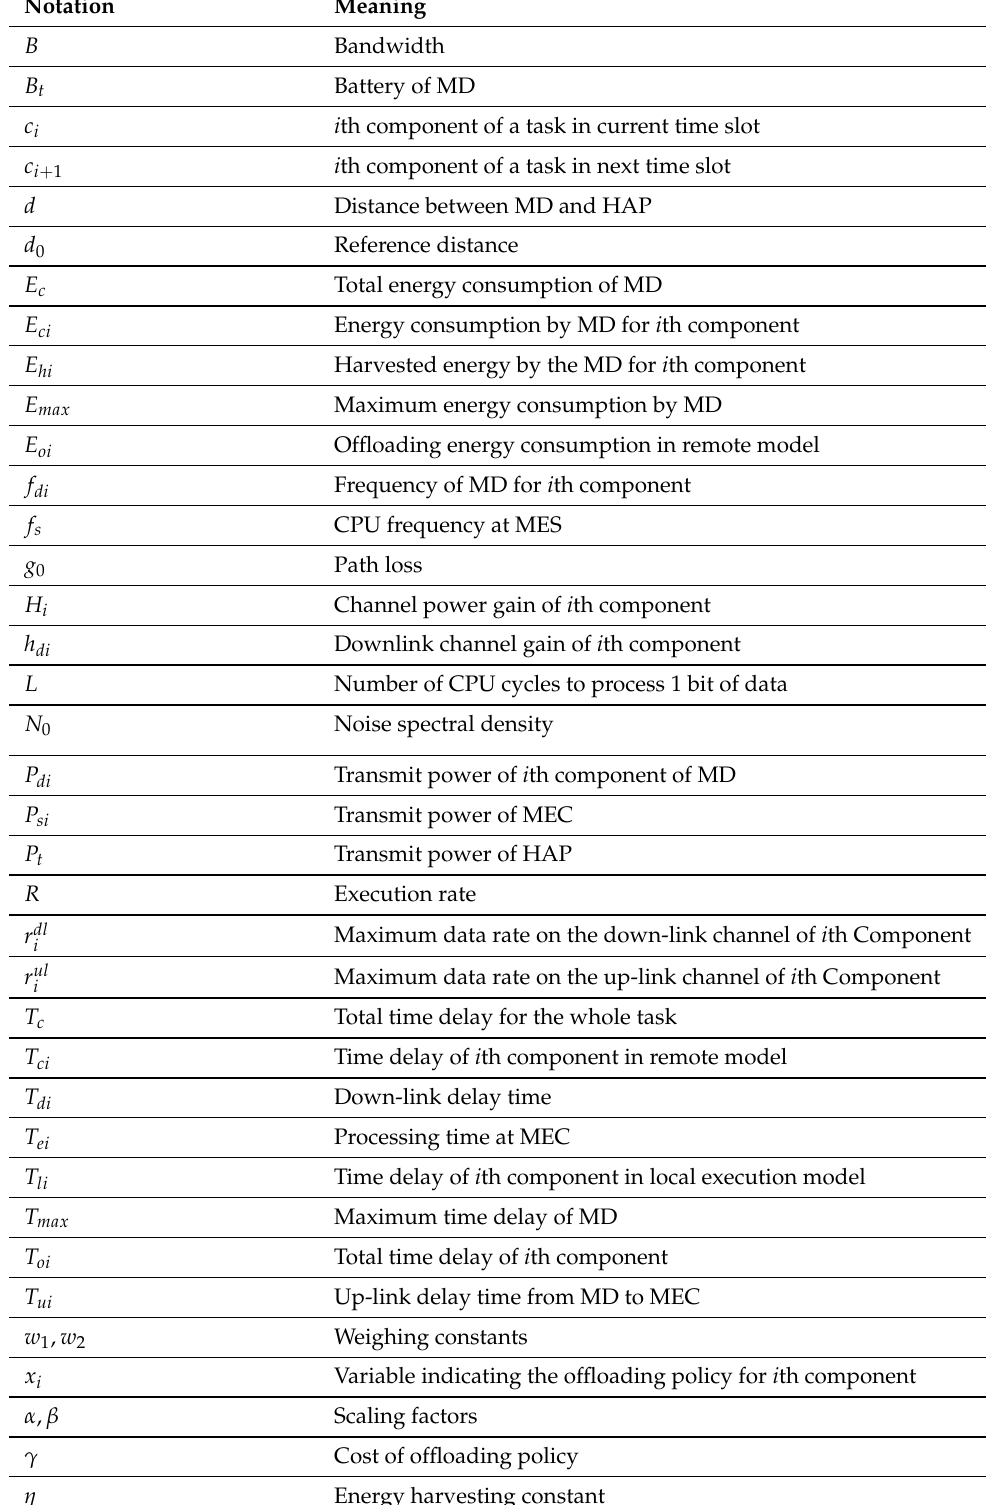
Table 3. List of notations